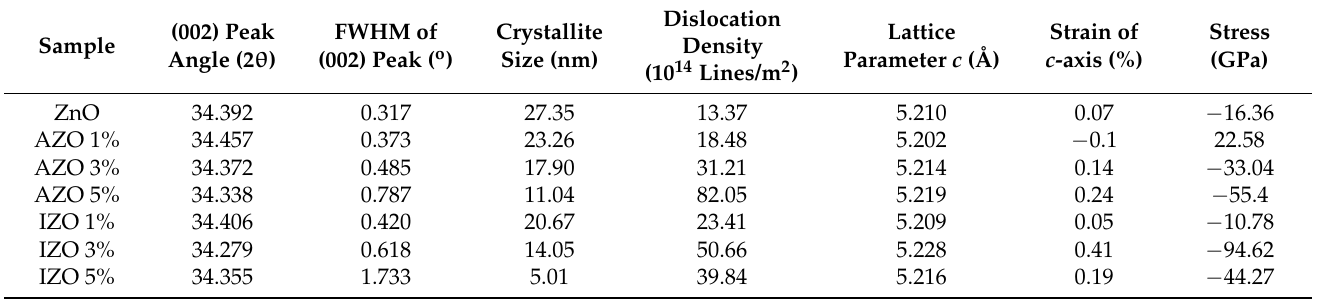
Table 1. Variation in the Bragg’s angle 2 θ ; the full width at half maximum; the crystallite size; lattice parameter c ; main strain ε ; and the stress of undoped ZnO, AZO, and IZO thin